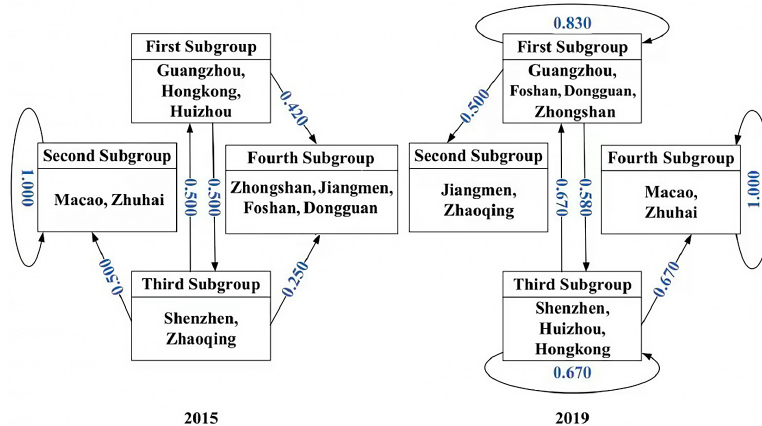
Note : The arrow values represent the connection density between subgroups. Figure 2. Association between the cohesive subgroups of the GBA’s green development spatial association network in 2015 and